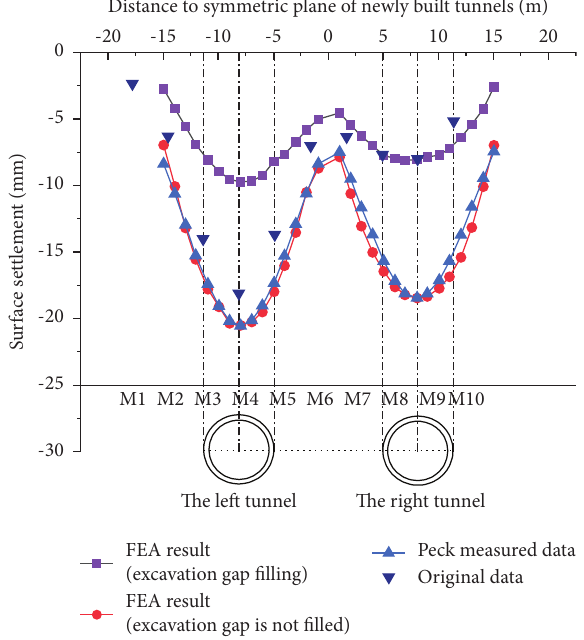
Figure 13: Comparison of ground surface settlement and the simulation